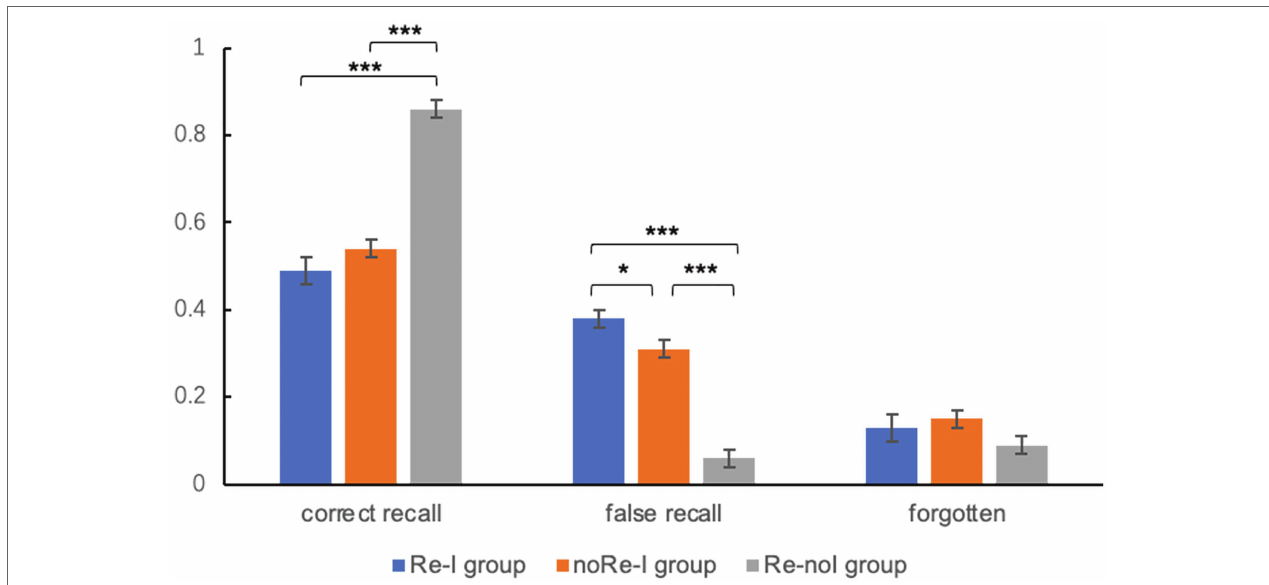
FIGURE 2 | Memory performance of cued recall tests among three groups (Experiment 1). For acronym, noRe-I represents the no Reactivation-Interference group; Re-noI represents the Reactivation-no Interference group; and Re-I represents the Reactivation-Interference group. For the results, the correct recall for the Re-noI group was significantly higher than that of the noRe-I and Re-I groups. The false recall for the Re-I group was significantly higher than that of both the Re-noI and noRe-I groups. The error bar in the figure represents the standard error. *represents p < 0.05 and ***represents p <